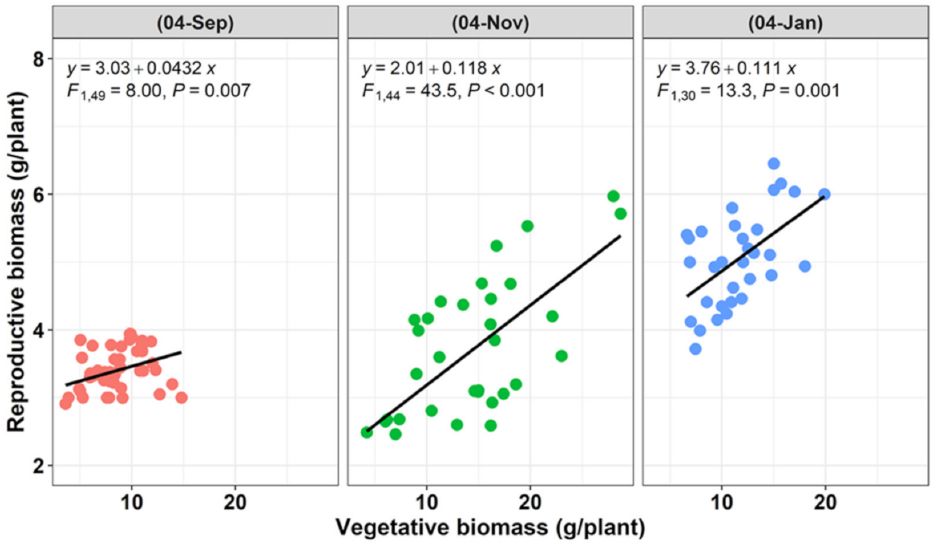
Figure 5. Relationship between biomass of reproductive and vegetative biomass of four populations of feathertop Rhodes grass at four different sowing